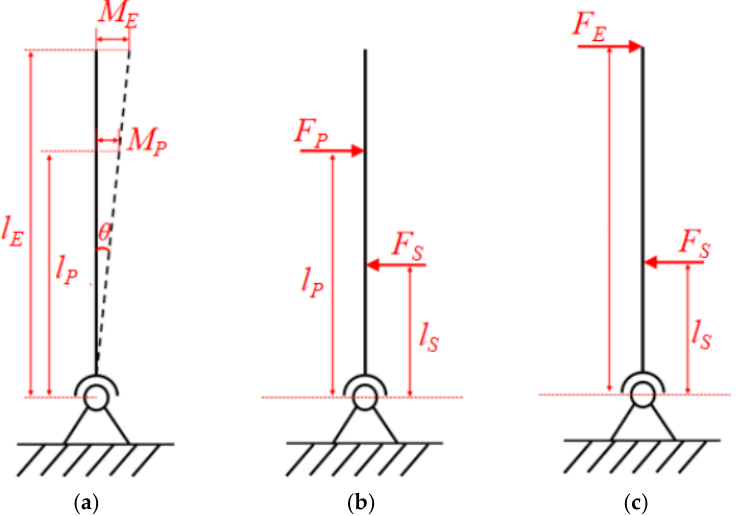
Figure 5. Diagrams of analysis of clamping forces and displacements. ( a ) Integral moment analysis; ( b ) Force analysis of the platform; ( c ) Force analysis of Gripper ’ s end.